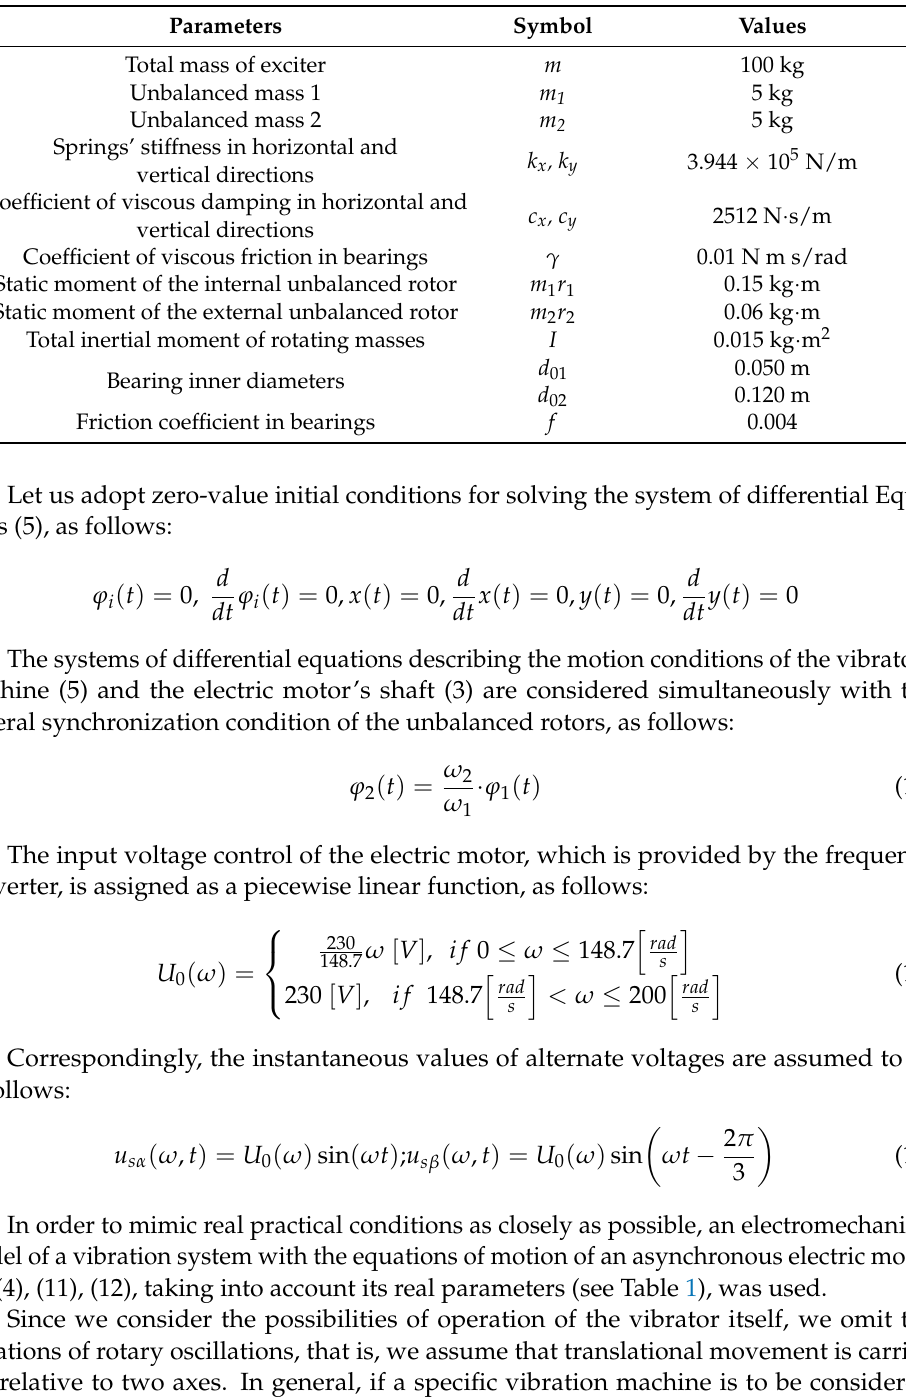
Table 2. Parameters of the vibratory